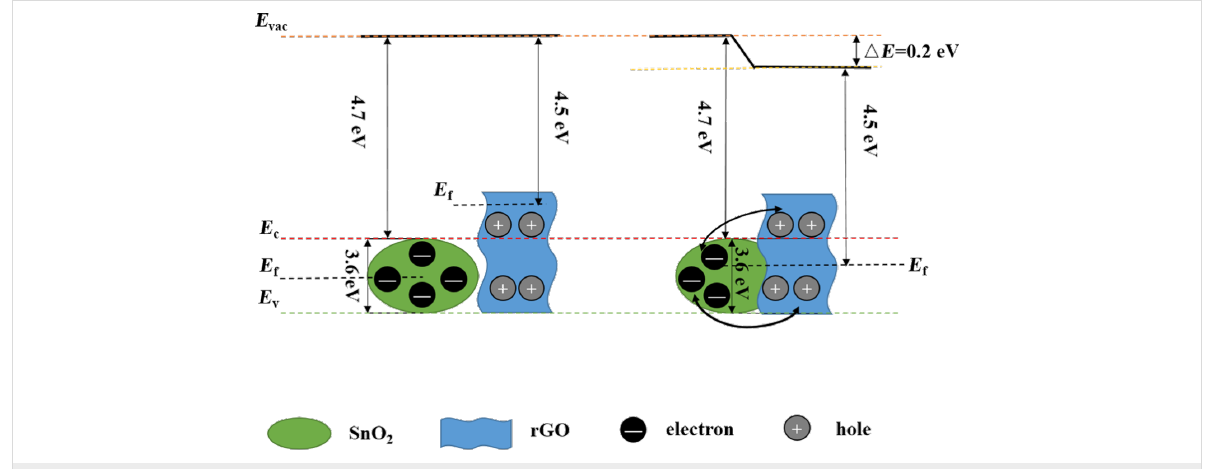
Figure 1: The band diagram of SnO 2 –rGO before and after the